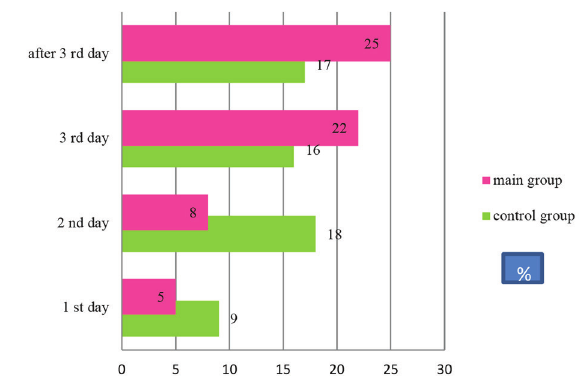
Figure 3 - Dynamics of improvement in the RR